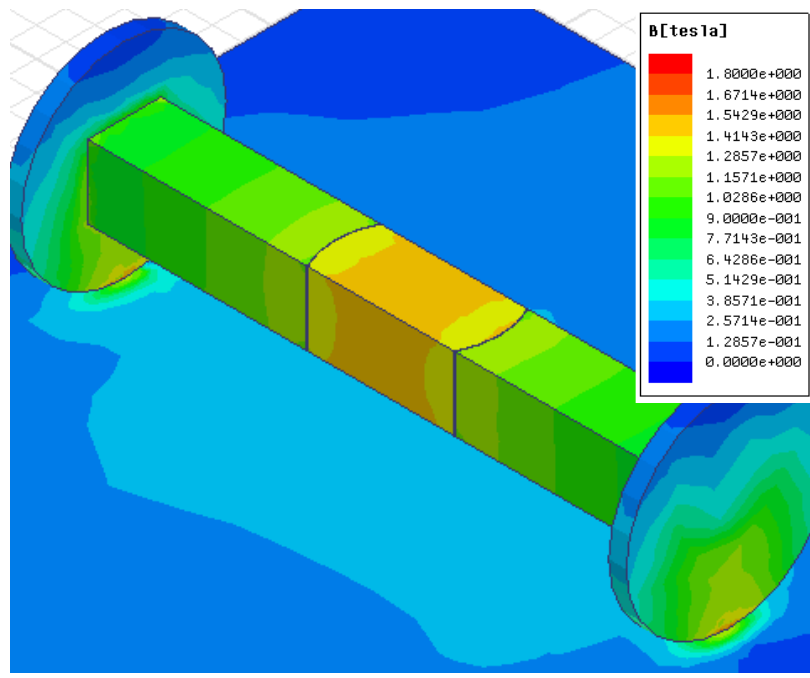
Figure 5. An example of 3D finite element analysis (FEA) showing flux density distribution.